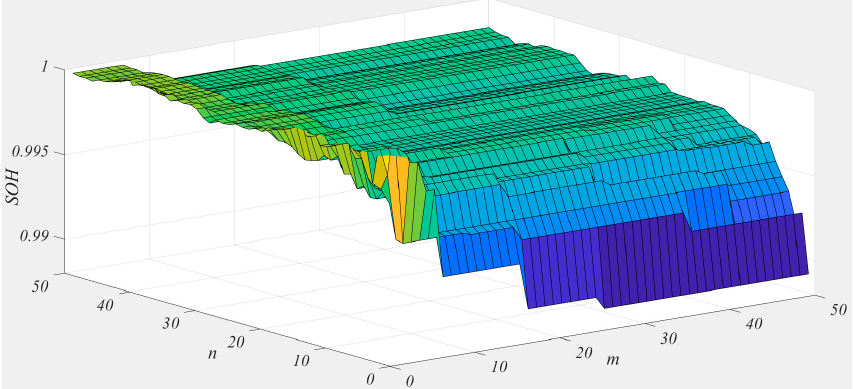
Figure 5. The changing trend of topology 2 battery pack SOH affected by C 0 .